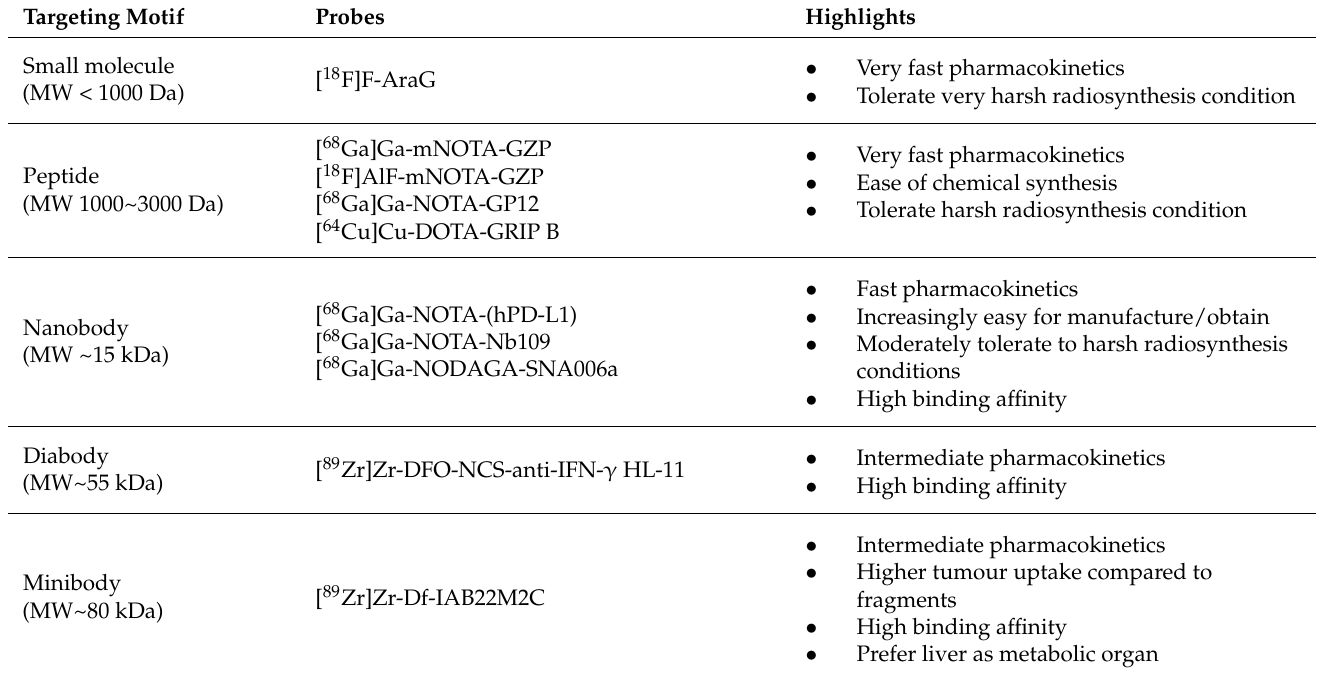
Table 3. Examples of PET tracers for cytotoxic T-cell and their